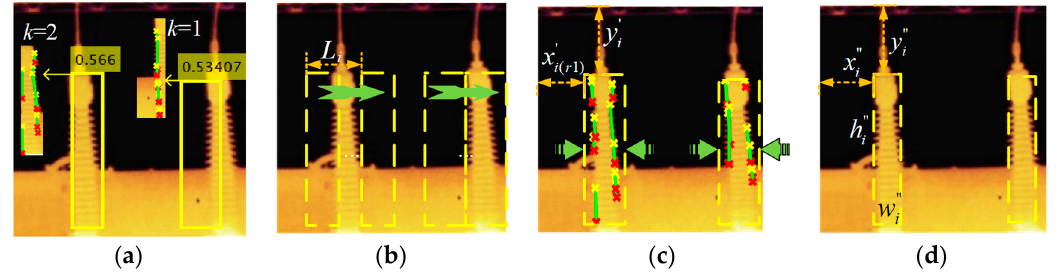
Figure 4. Schematic diagram of the sliding window (SW) correction process using the Gap statistic